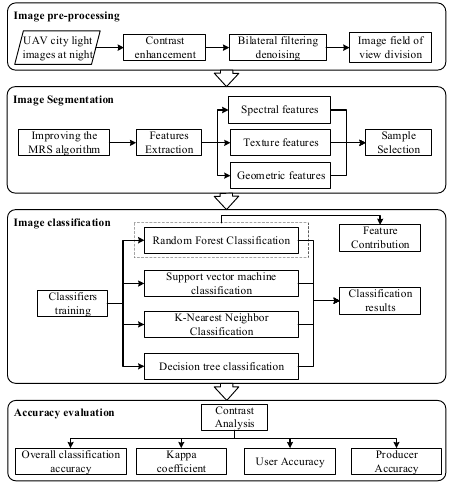
Figure 2. UAV nighttime city light image classification flow chart .